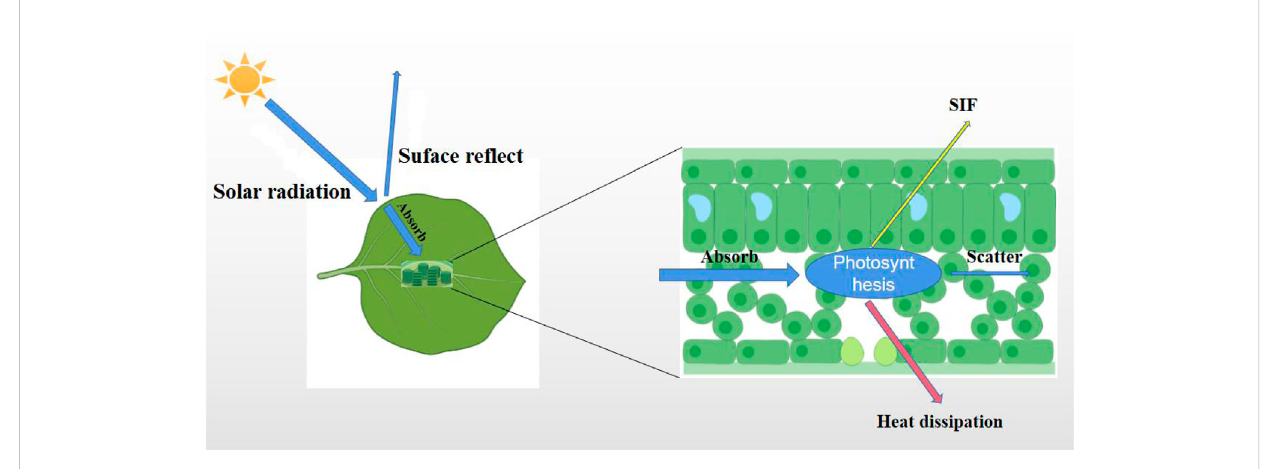
FIGURE 3 The combined process between photosynthesis and SIF.